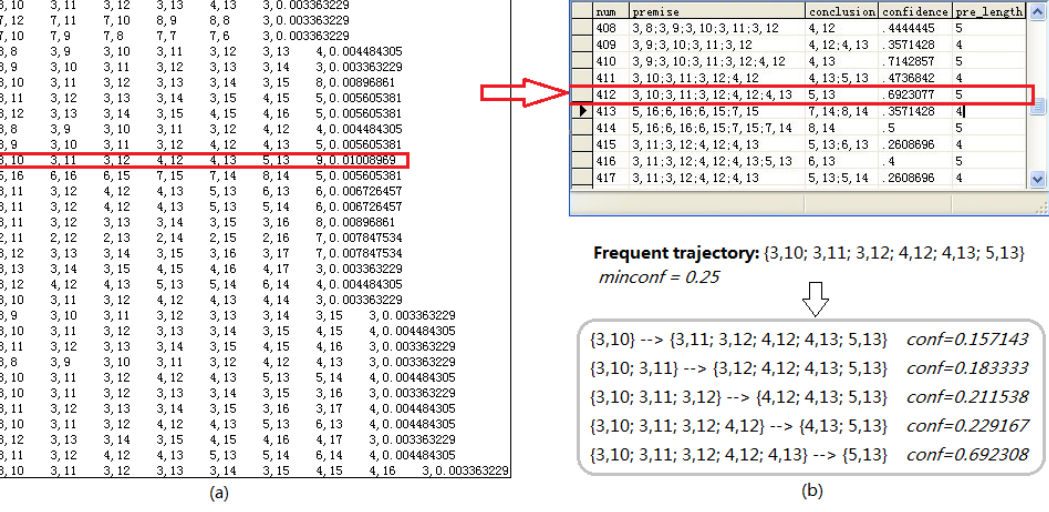
Fig. 5. Mining motion patterns. (a) frequent trajectory mining; (b) association rules generating.